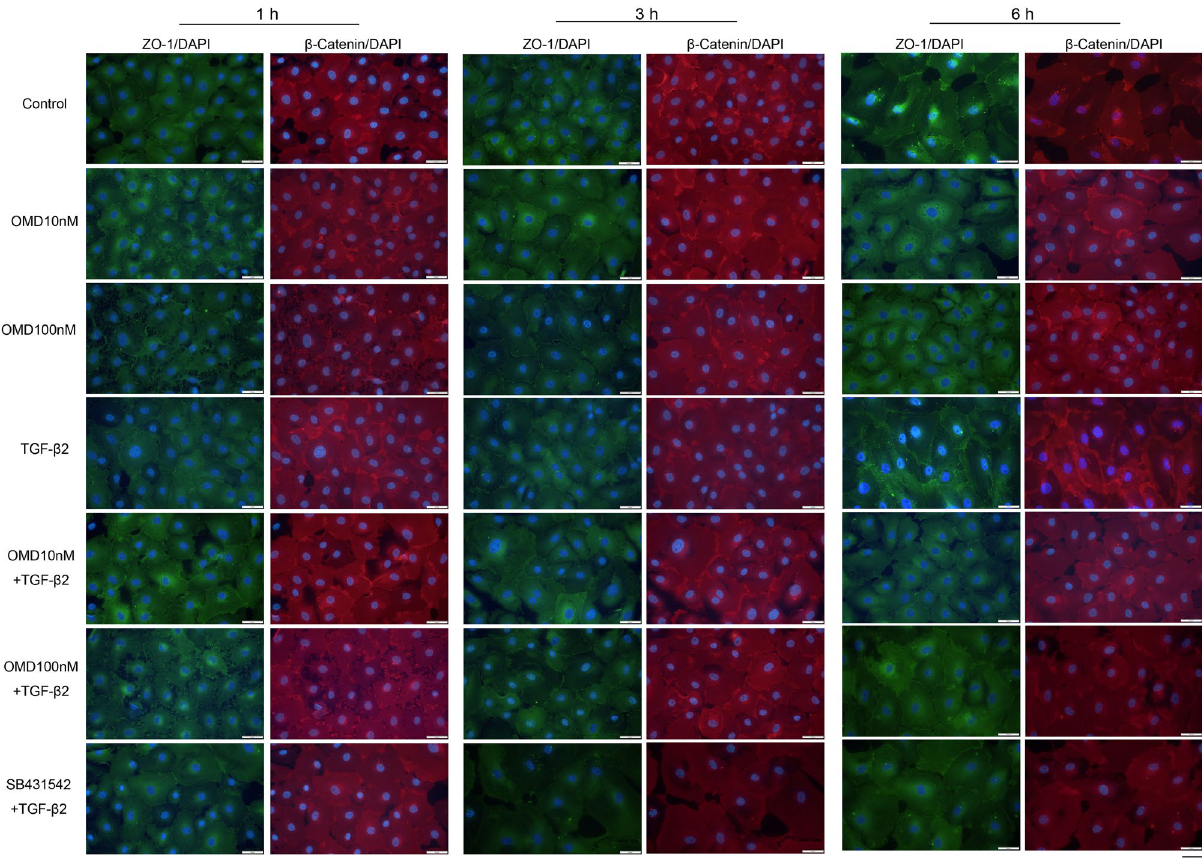
Figure 4. Effects of OMD on tight-junction-related protein expression in Schlemm’s canal endothelial (SCE) cells. The effects of OMD on TGF-β2-induced tight-junction-related protein expression in monkey SCE cells. The samples were pretreated with TGF-β2 for 1 h and fixed at 1, 3, 6 h after the stimulation with OMD. At 1 and 3 h after stimulation, SCE cells were stained with ZO-1 (green) and β-catenin (red). Cell nuclei were counterstained with DAPI (blue). Compared to the control, OMD (especially 100 nM) disrupted the stained areas of ZO-1 and β-catenin. Similar changes were seen between the OMD and TGF-β2 treatments. Scale bars: 50